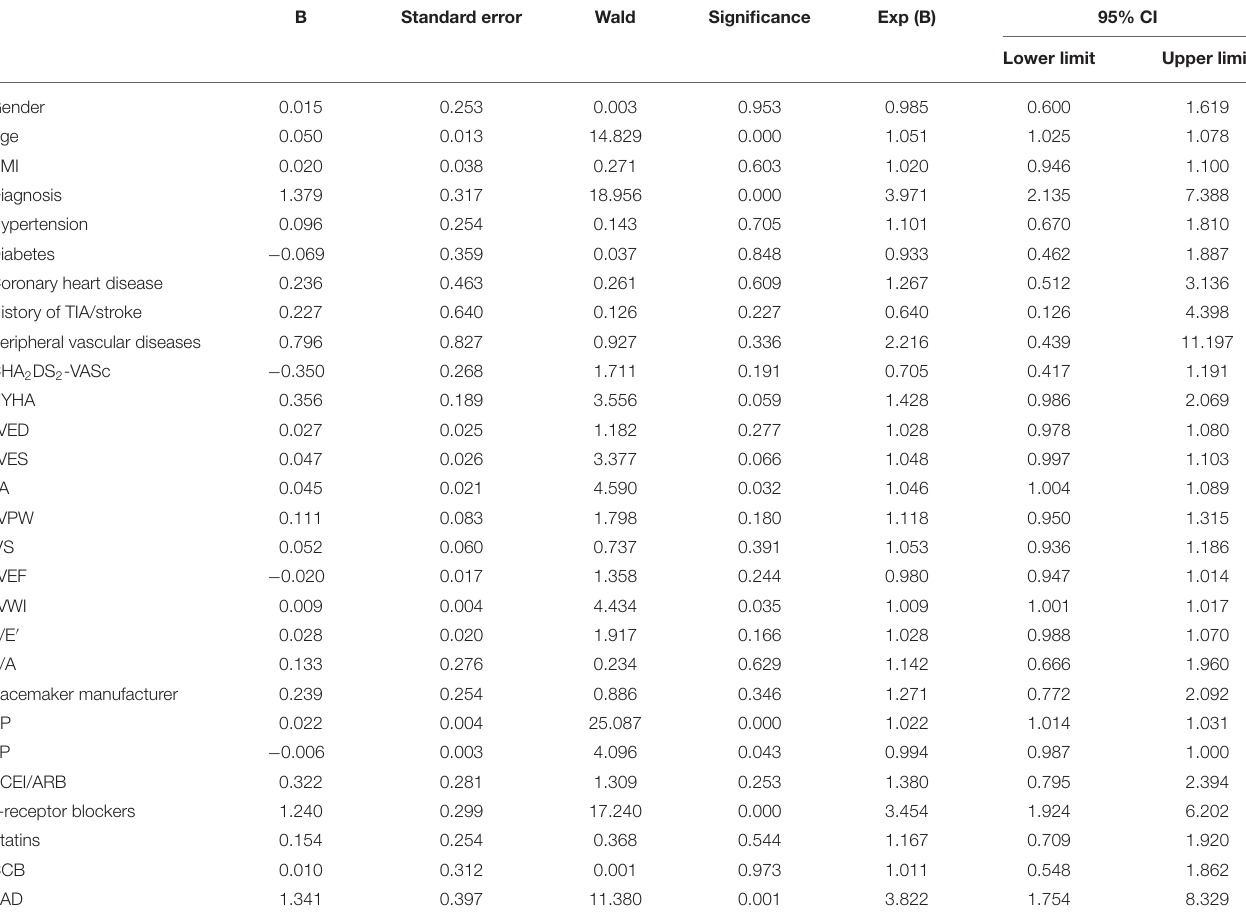
TABLE 3 | Binary univariate logistic regression analysis of AHREs.